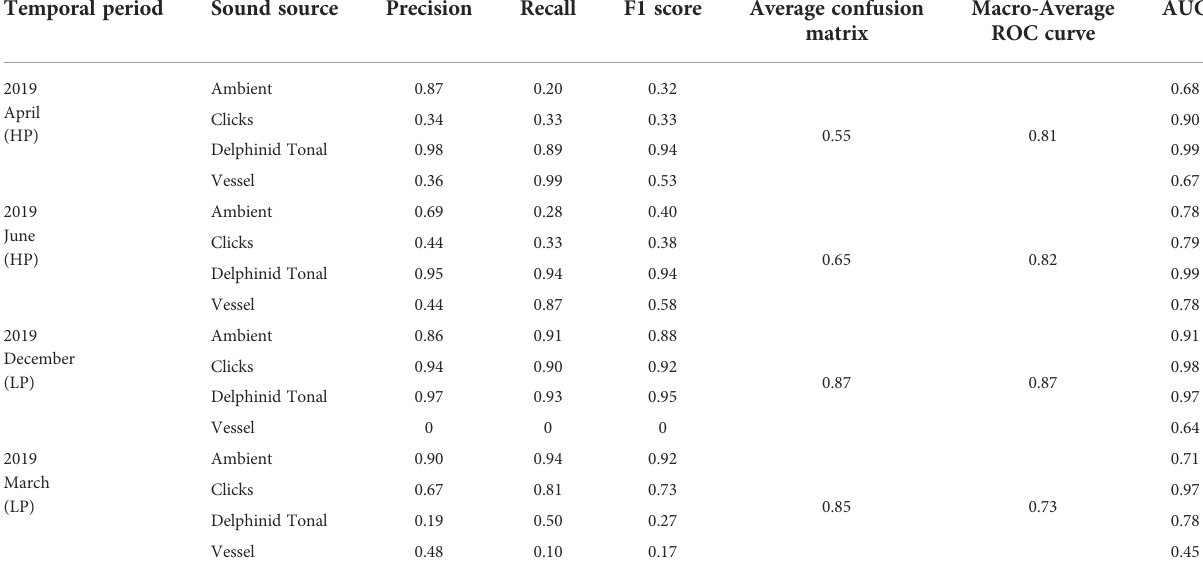
TABLE 5 Performance metrics computed for model evaluation in high pressure (HP) and low pressure (LP) weather conditions, demonstrating seasonal variation. Temporal